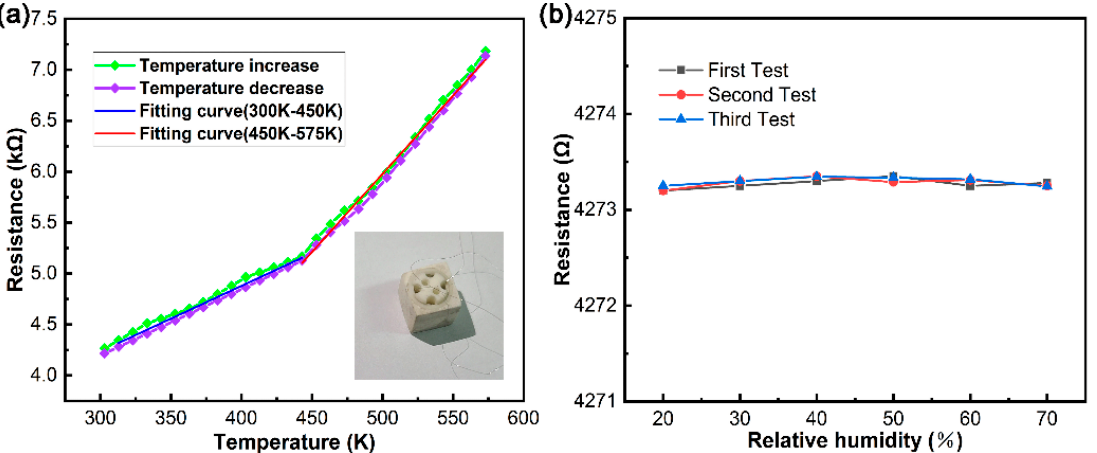
Figure 6. ( a ) The resistance of the temperature sensor as a function of temperature. ( b ) Humidity characteristics of the device.